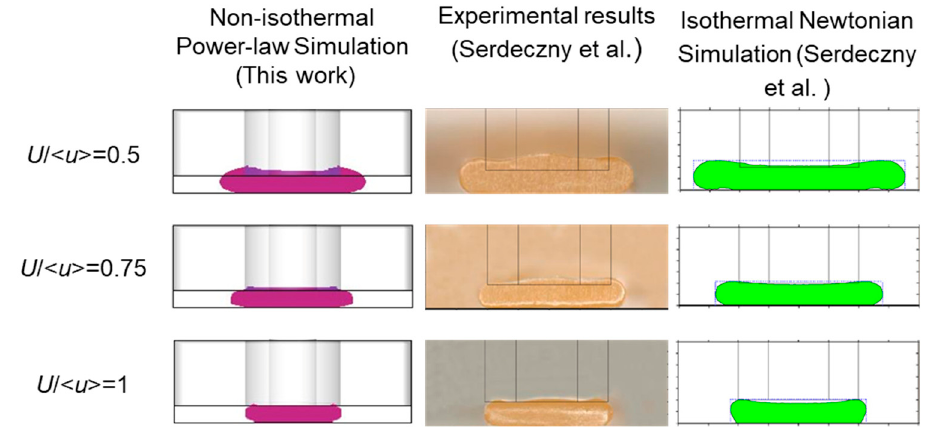
Figure 11. Comparison of the cross-sections obtained from simulations and experiment (The images were adapted from Serdeczny et al. [15] by permission from Elsevier).